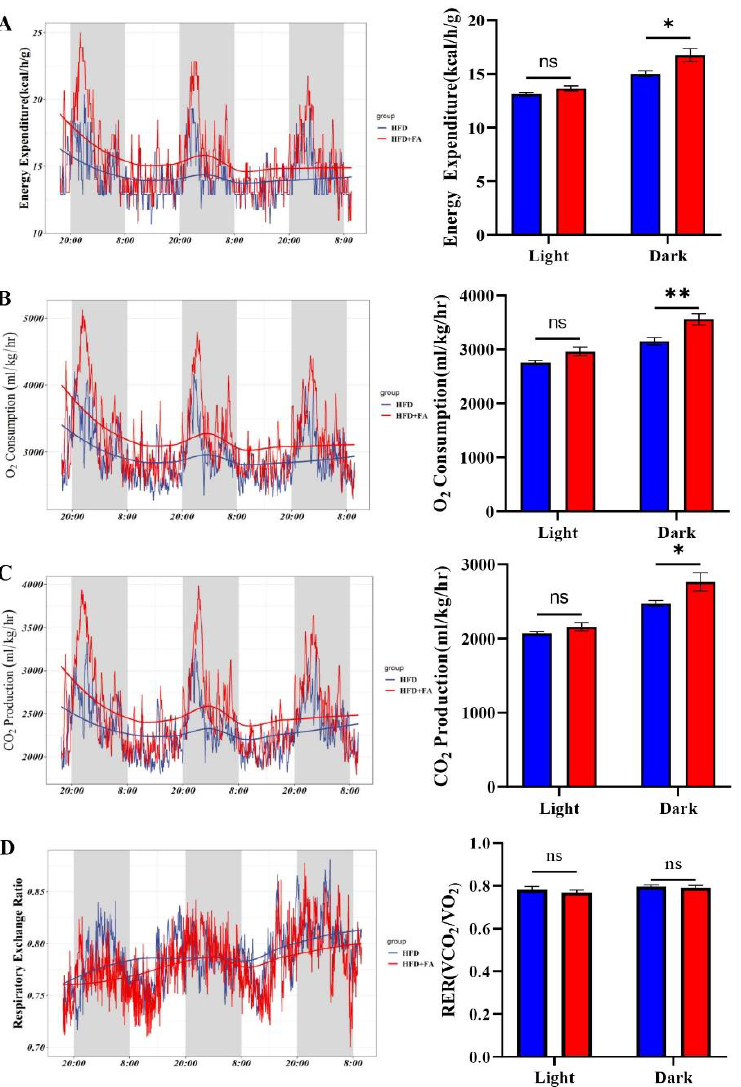
Figure 6. FA increases energy expenditure. ( A ) Energy expenditure; ( B ) oxygen consumption; ( C ) carbon dioxide production; and ( D ) Respiratory exchange ratio (RER) of mice from HFD and HFD+FA groups ( n = 4). Data are shown as mean ± SEM. * p < 0.05, ** p < 0.01.